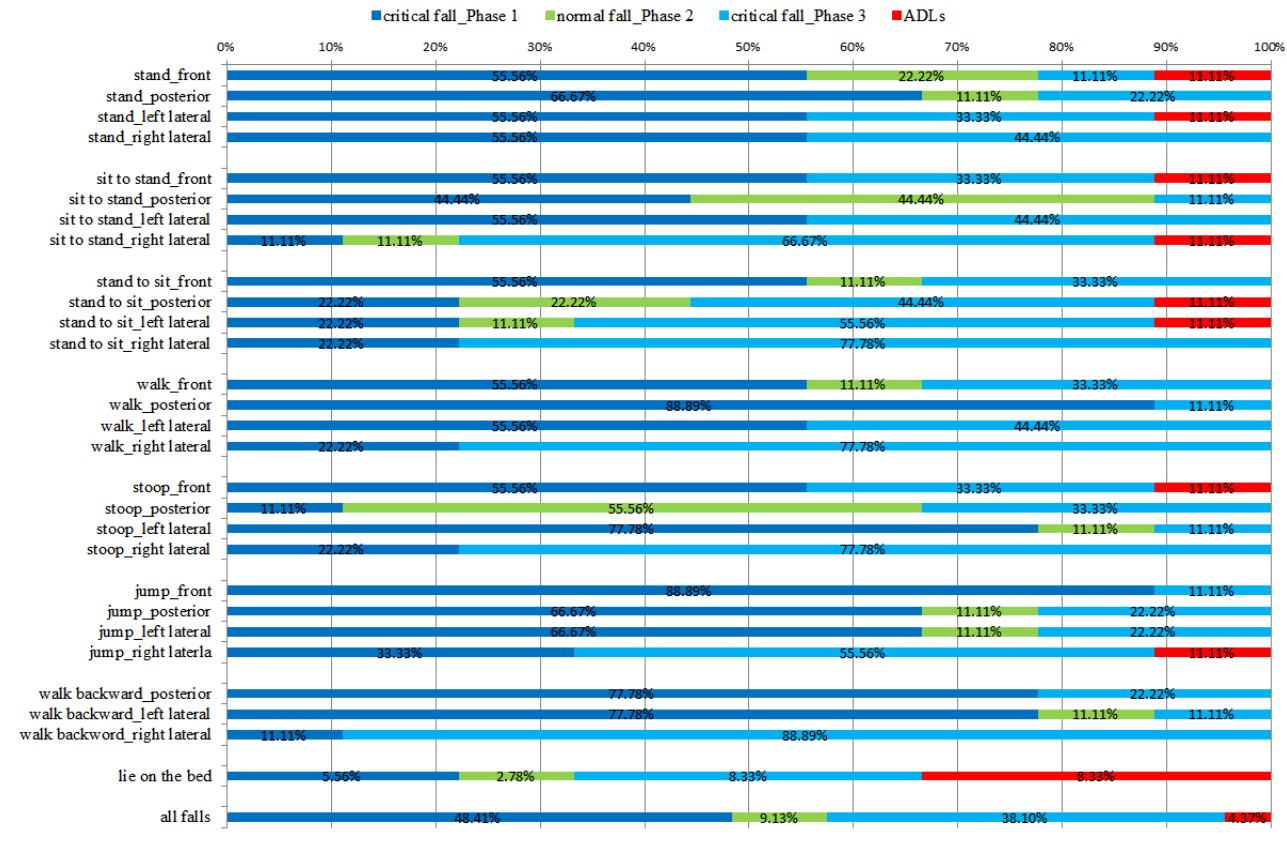
Figure 7. The detection results of falls using the proposed fall detection